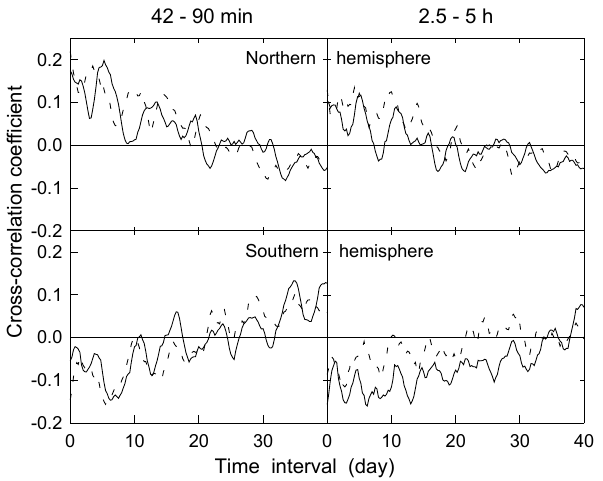
Fig. 8. Fig. 8. Coherence spectra derived from the temporal dependence of cross-correlation coefficients, shown in Fig. 7. Solid and dashed lines denote the same as in Fig.